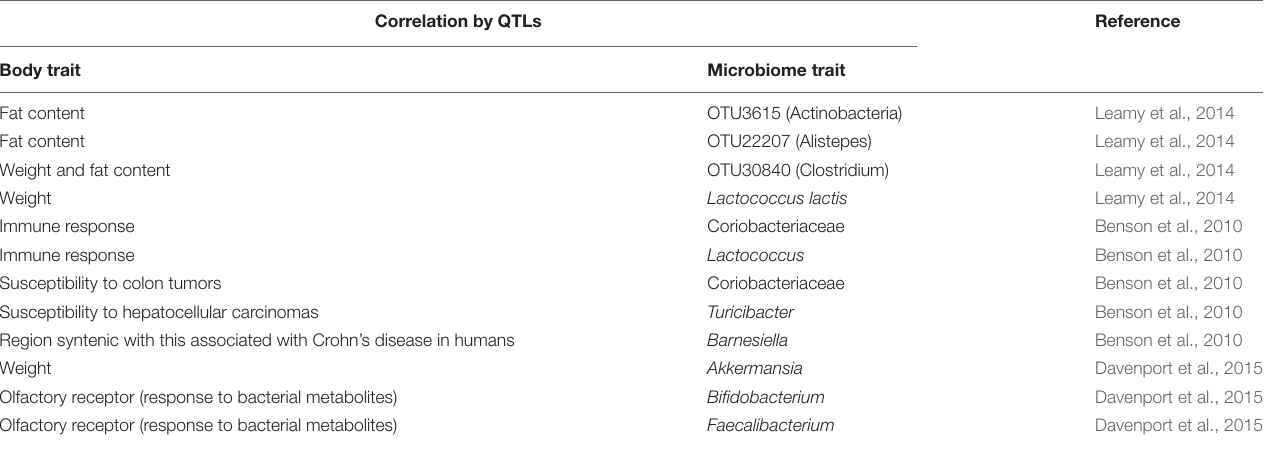
TABLE 1 | Correlations of body traits and microbiome traits by the same quantitative trait loci. Correlation by